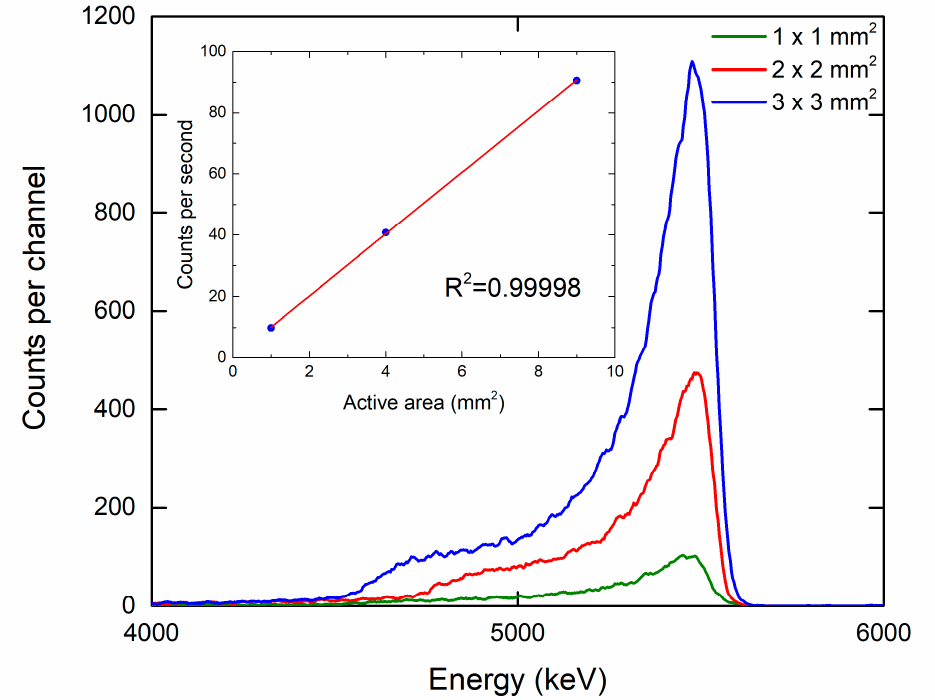
Figure 7. Response of 4H-SiC detectors with different active surface areas (1 × 1 mm 2 , 2 × 2 mm 2 and 3 × 3 mm 2 ) to the Am-241 alpha particles with linear regression. We can observe excellent collation of 4H-SiC detector response over the active detector area. There is no decrease in sensitivity of 4H-SiC detectors by increasing its active area.